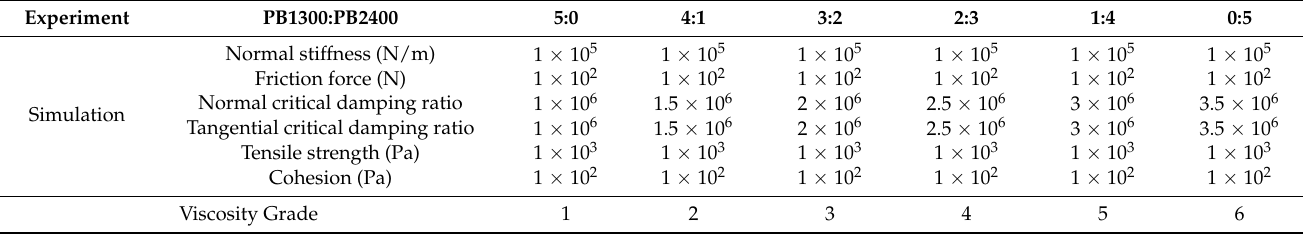
Table 2. The composition and contact model parameters of the sealing grease samples at different viscosity